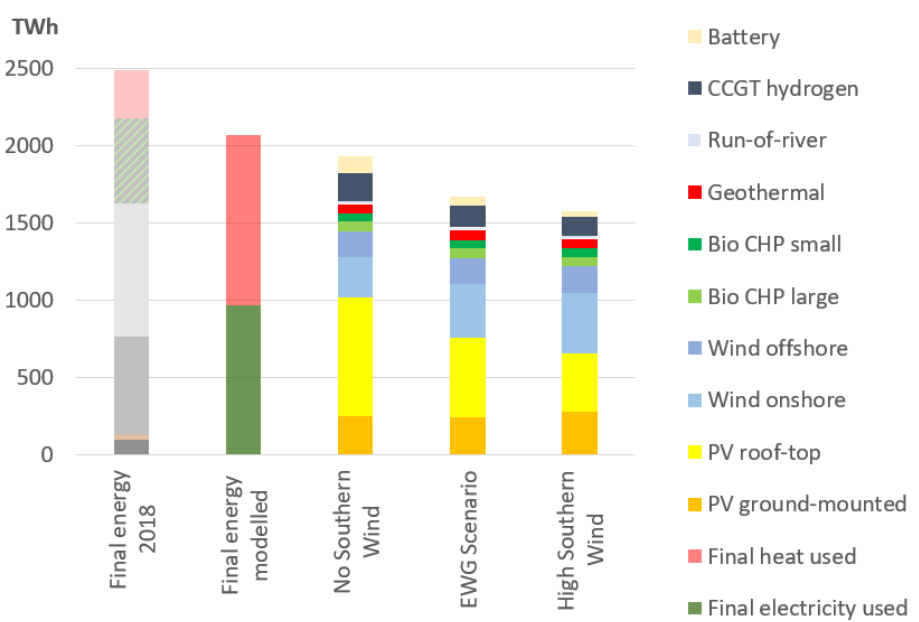
Figure 6. Final energy supply and electricity generation in Germany (in TWh) in the scenarios; for comparison, the left bar represents the final energy supply in 2018. In particular, electrification of the transport and heating sectors, which were still largely based on fossil fuels in 2018 (light gray and black), yields significant efficiency improvements in the target scenario (EWG